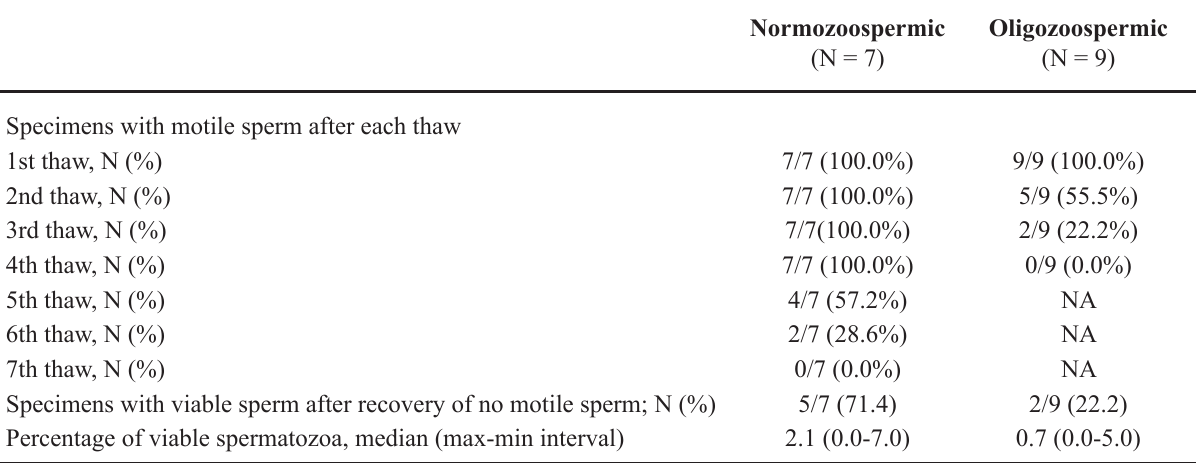
Table 3 – Frequency of recovery of motile spermatozoa after each thaw in both normozoospermic and oligozoospermic specimens, and percentage of viable spermatozoa after recovery of no motile